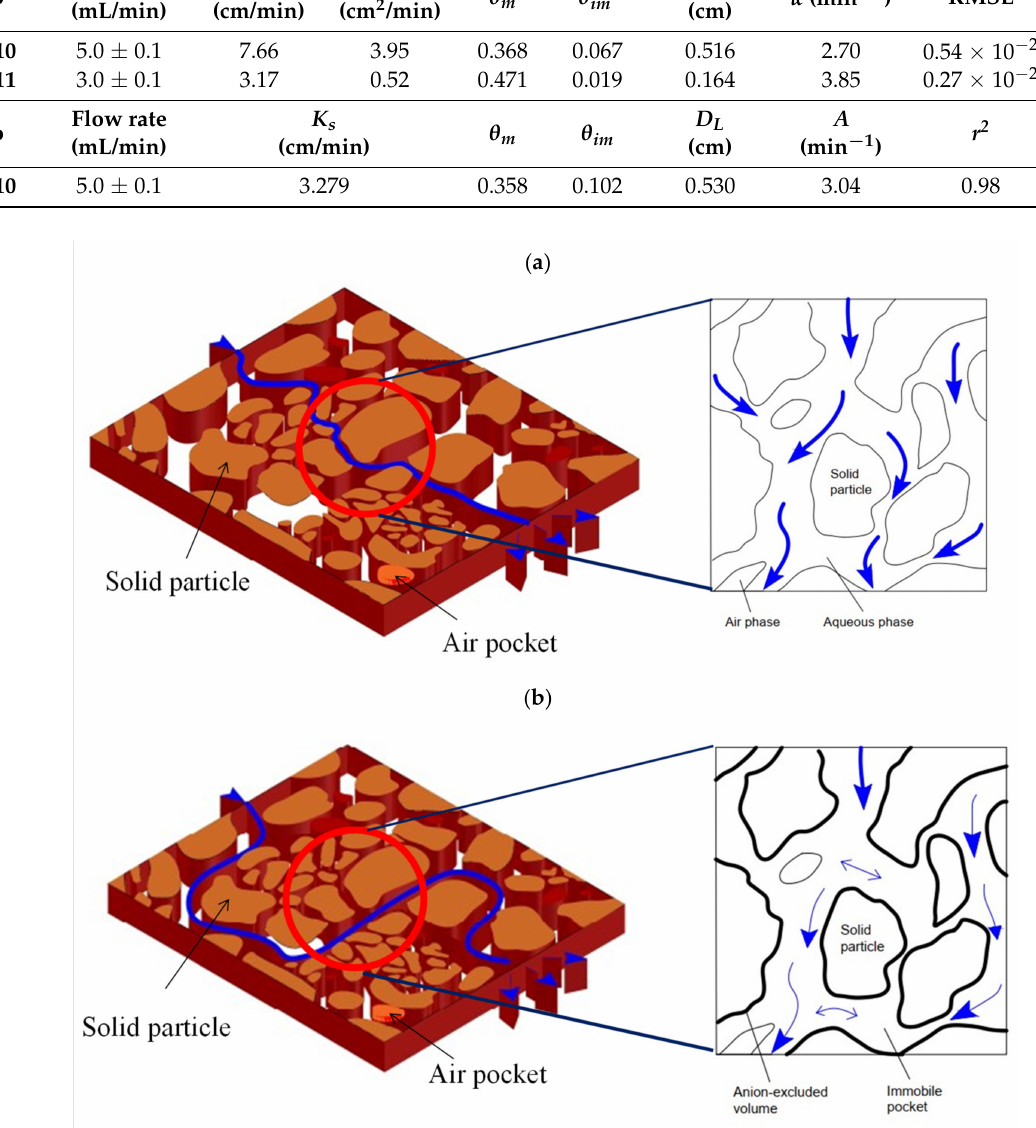
Figure 6. Schematic model of HTO and I − transport. ( a ) HTO; ( b ) I −